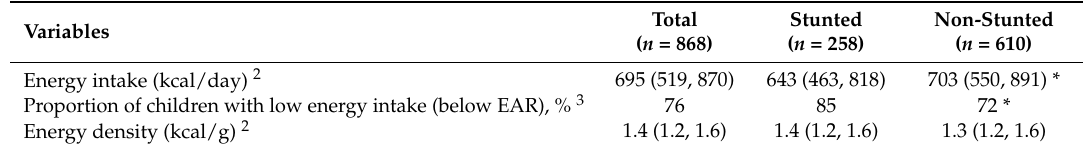
Table 4. Energy intake of children 1 .